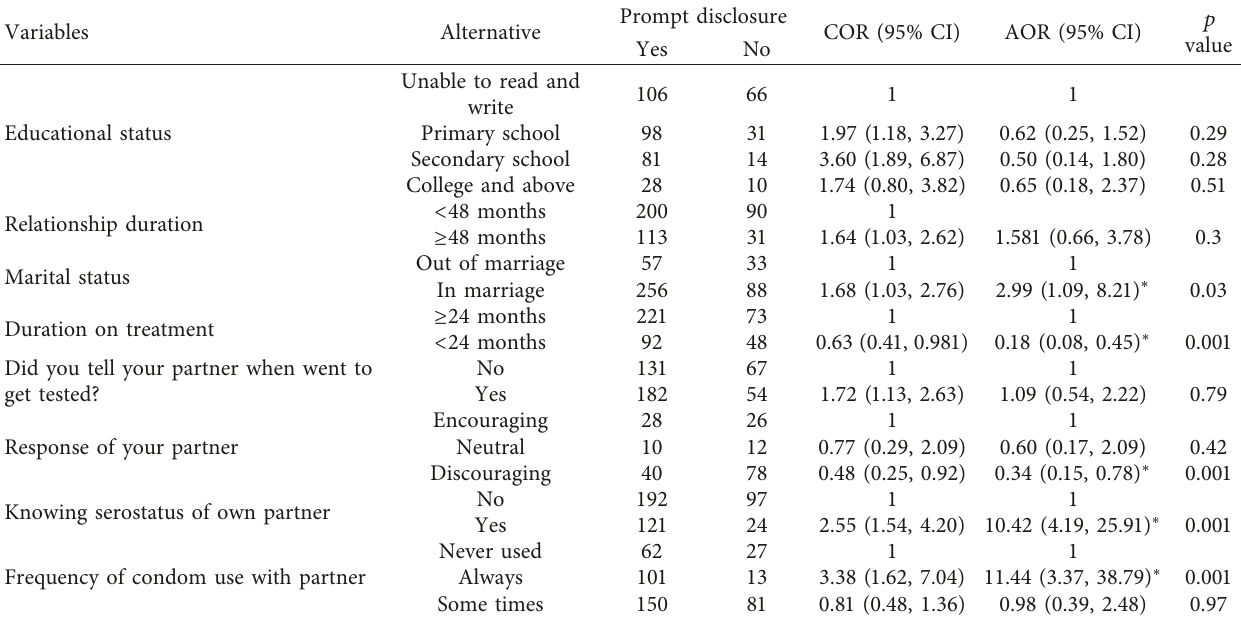
Table 4: Factor associated with prompt HIV-seropositive status disclosure to the partner among clients on ART at Holeta Health Center, central Ethiopia,